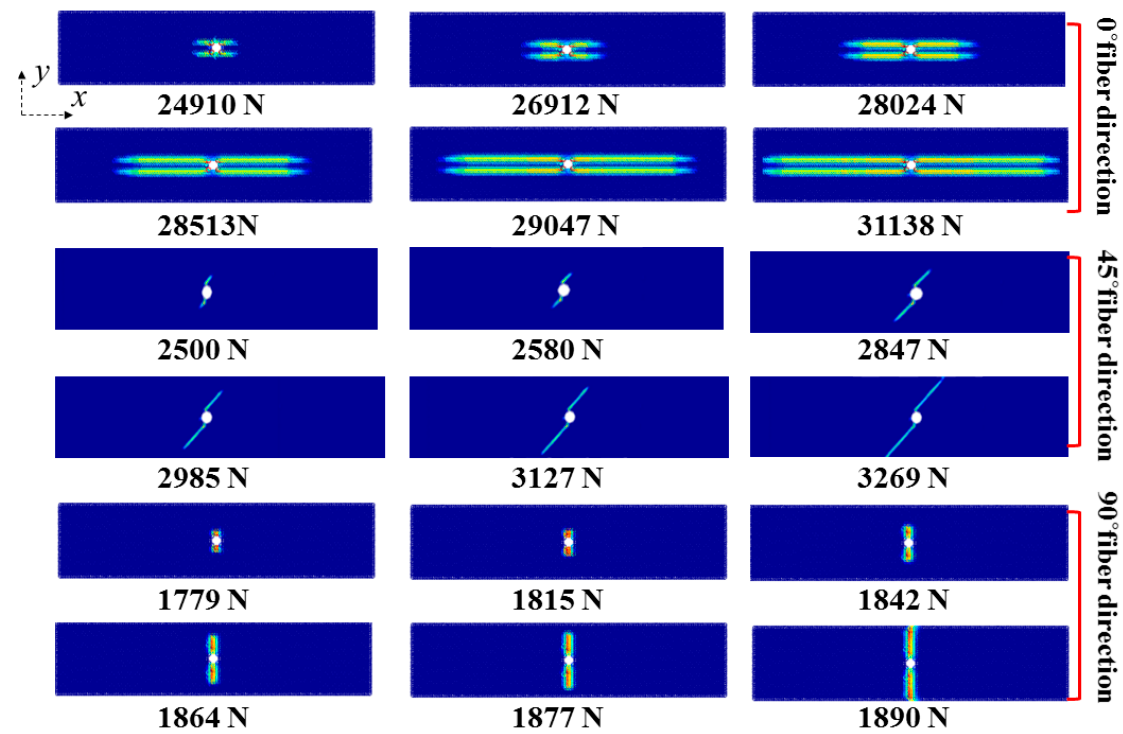
J. Compos. Sci. 2021 , 5 , x FOR PEER REVIEW